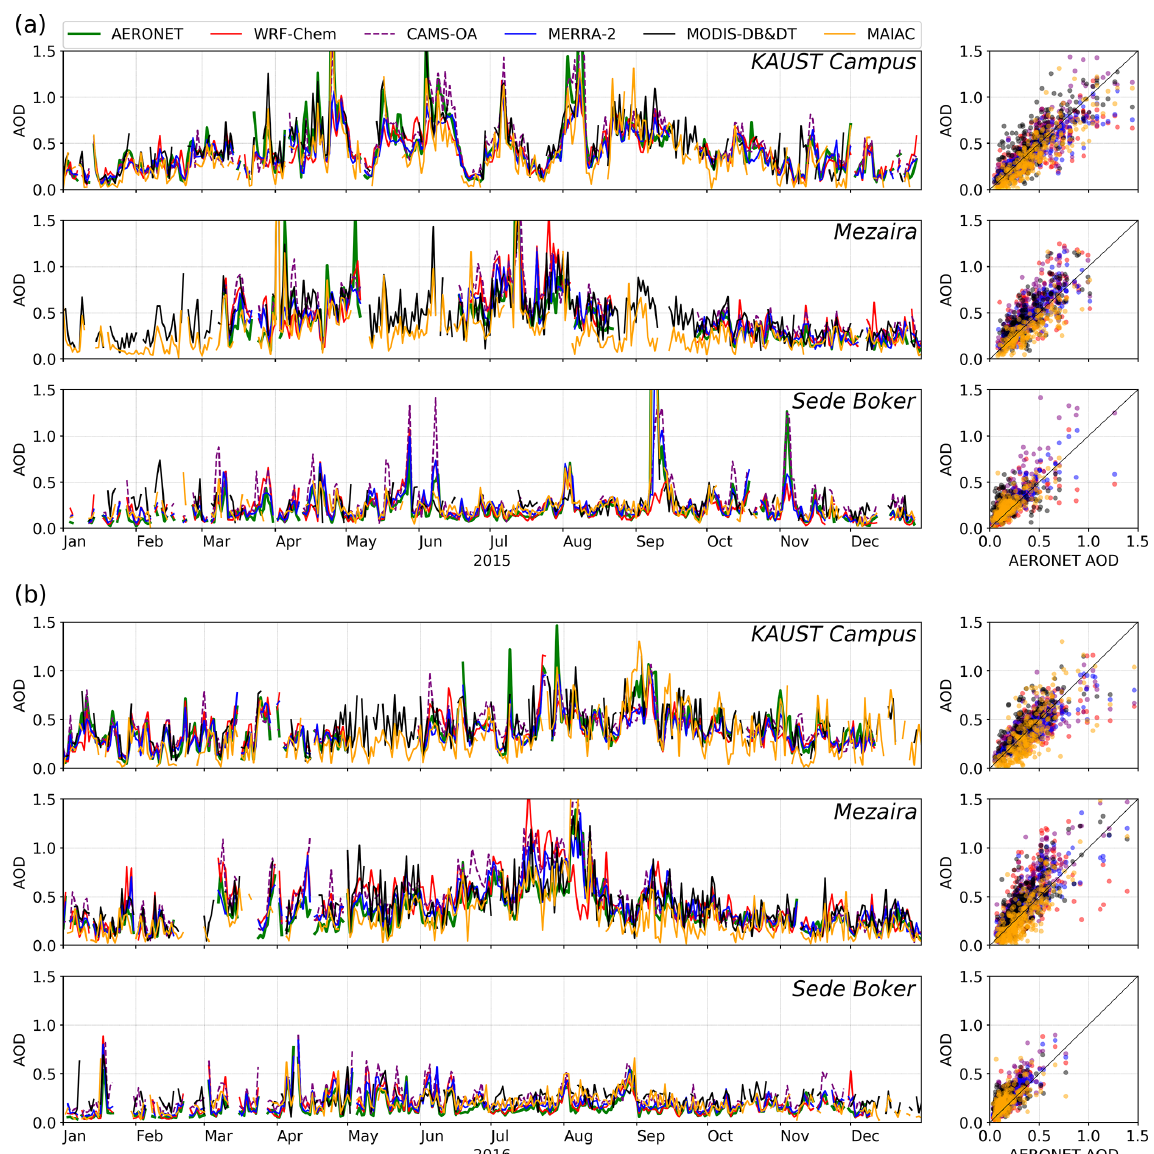
Figure 6. Daily averaged AOD at three AERONET sites (KAUST Campus, Mezaira, Sede Boker) and corresponding scatter plots computed for WRF-Chem, AERONET, MERRA-2, CAMS-OA, MODIS-DB&DT, and MAIAC: (a) 2015, (b)